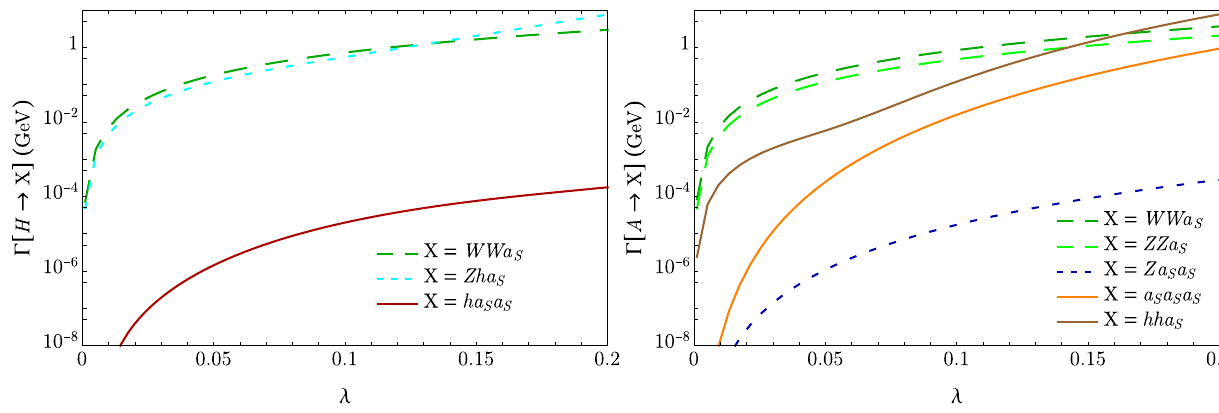
Fig. 6 Bosonic three-body decay widths of the heavy doublet-like Higgs bosons, involving a S in the final state, in the scenario of Fig.